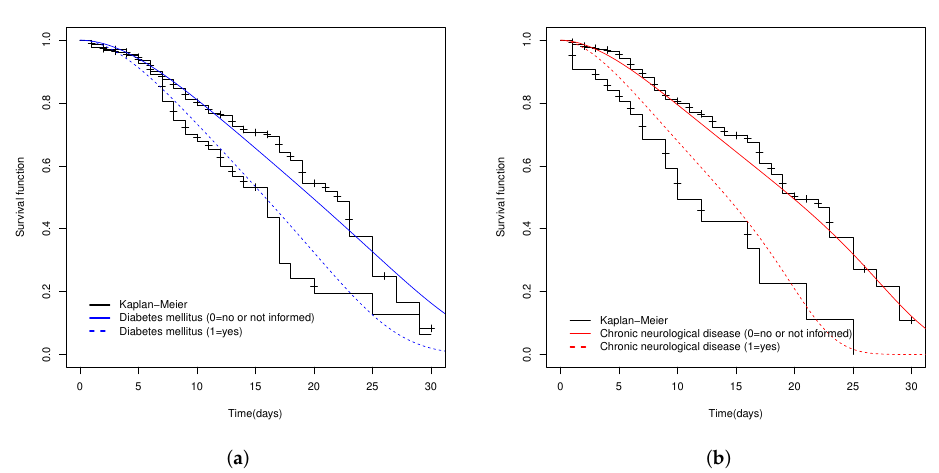
Figure 9. Estimated and empirical survival functions: ( a ) Diabetes mellitus; ( b ) chronic neurologi- cal disease.